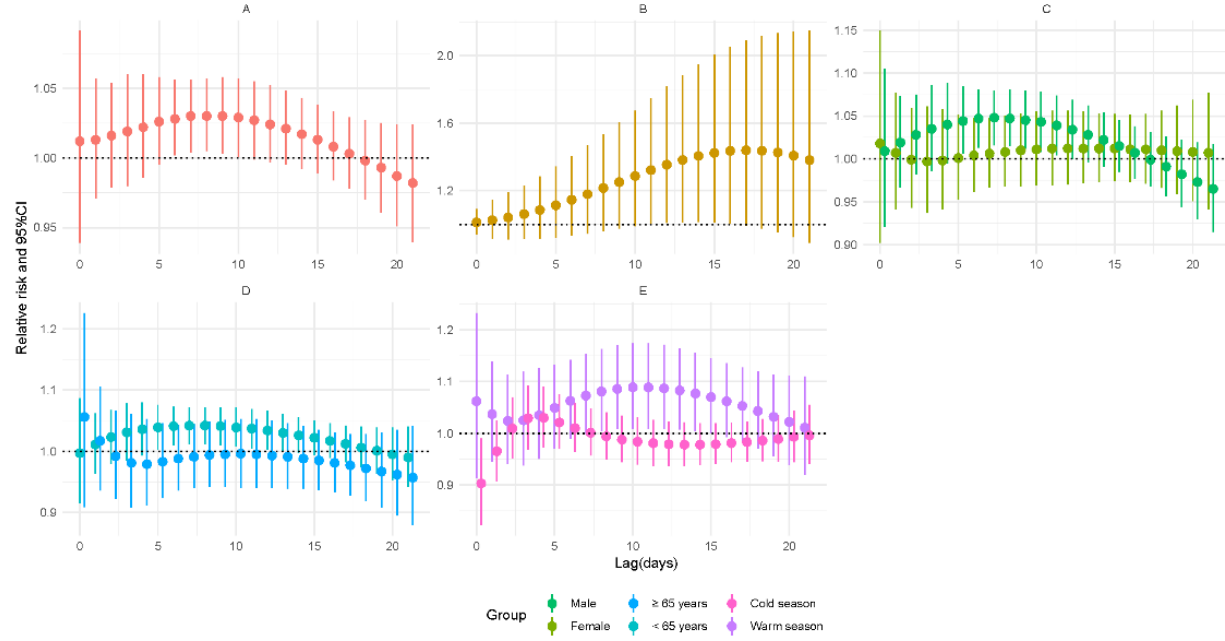
Figure 5. Relative risks for tuberculosis incidence in relation to a 100 µ g/m 3 increase of daily average concentrations of carbon monoxide (CO). ( A ) Lag-specific RRs; ( B ) cumulative RRs; ( C ) stratified analysis by gender; ( D ) stratified analysis by age; ( E ) stratified analysis by season.